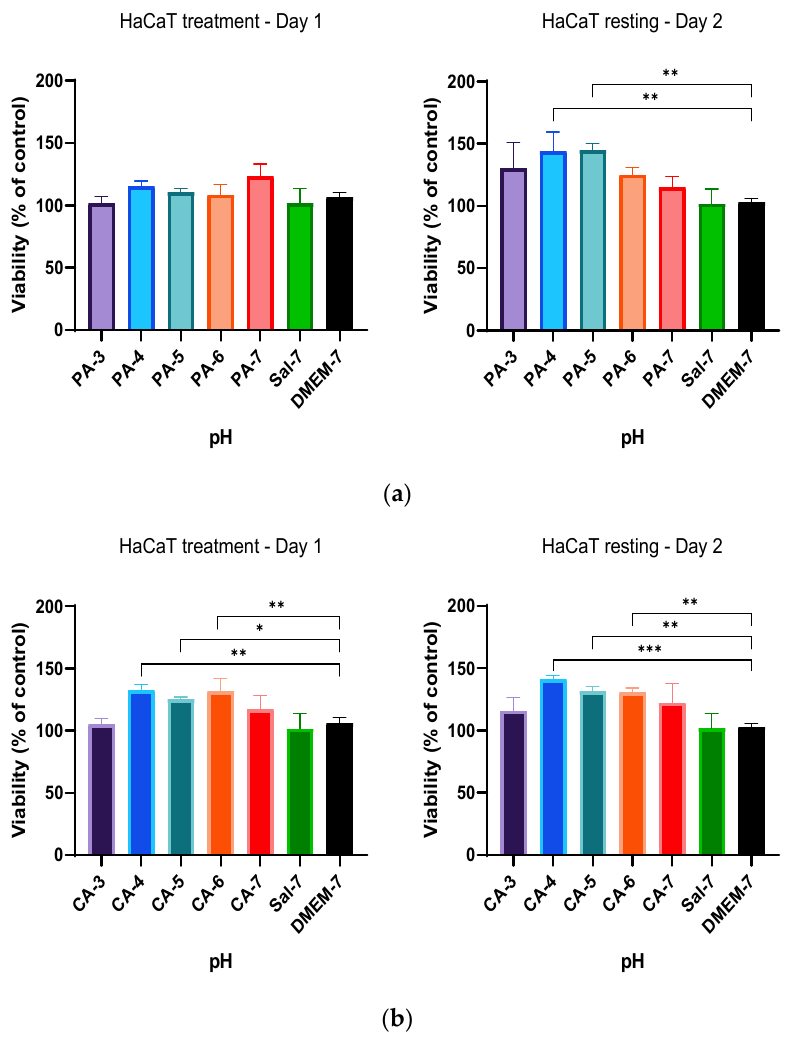
Figure 5. Percentage viability of HaCaT cells with a 24 h treatment with ( a ) 0.01 M phosphoric acid (PA) and ( b ) 0.01 M citric acid (CA), with pH ranges from 3 to 7, followed by a 24 h resting period with DMEM-7 replacement. The viability of HaCaT cells was significantly higher after treatment with 0.01 M phosphoric acid pH 4 and 5 (PA-4 and PA-5). The percentage viability of HaCaT cells was also observed to be statistically significant after treatment of 0.01 M citric acid buffers with pH values of 4, 5 and 6 (CA-4, CA-5 and CA-6). Each bar represents the mean ± standard deviation. * p < 0.05, ** p < 0.01 and *** p < 0.001 indicates that the results obtained were statistically significant from those of the control group